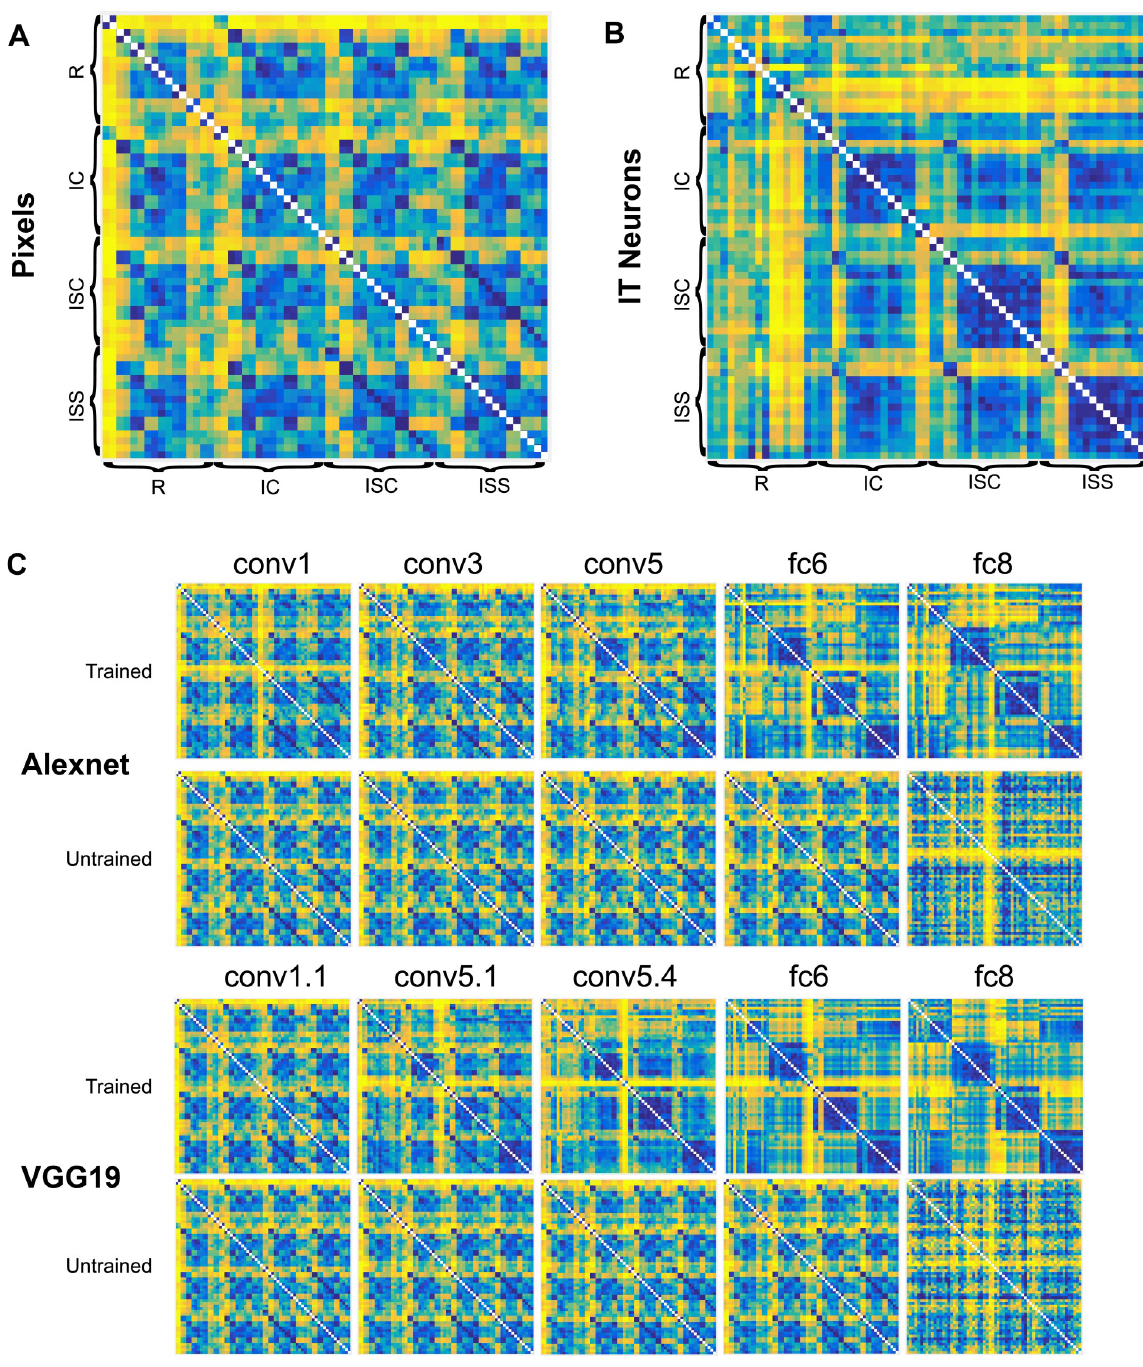
Fig 3. Dissimilarity matrices. Matrices of Euclidean distances for pixel gray-levels (A), the IT neurons (B), and 5 layers of the trained and untrained versions of 2 deep CNNs (C). Note that the dissimilarity matrices are by definition symmetric about the diagonal of zeros, which is plotted in white color. The stimulus groups are indicated in (A) as in Fig 1 and the CNN layers in (C) have the same terminology as in Fig 2. The matrices have been separately normalized and are plotted in percentile units, following [23]. Dissimilarities increase from blue to yellow.